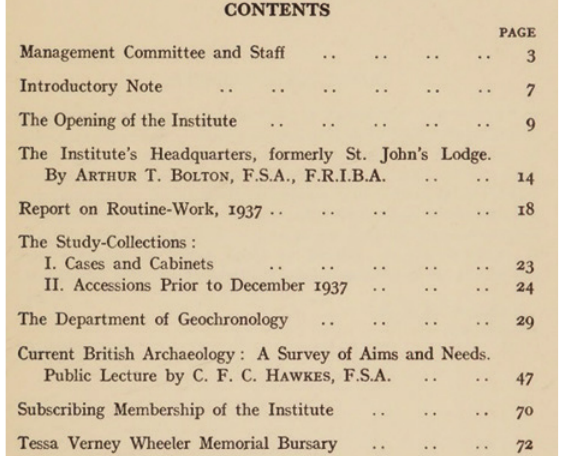
Figure 2 Contents page of the Annual Report of the Institute of Archaeology 1. This first report set out the ‘template’ for all future volumes and reveals the subjects considered by the Institute to be of interest to its subscribers and public audience (Source: Digital collections. UCL Library